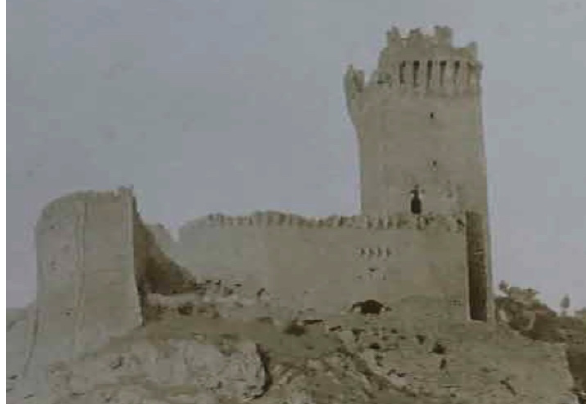
Figure 3. The Stronghold, beginning of the XX century